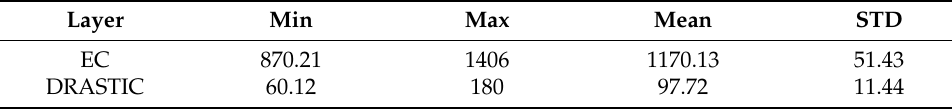
Table 5. Statistics of individual